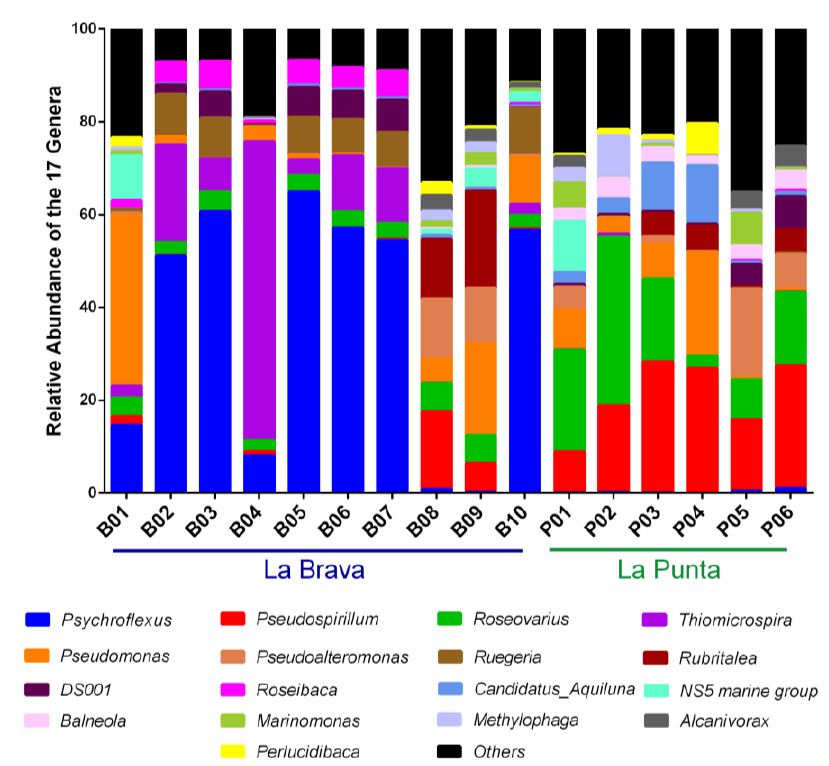
Figure 4. Relative abundance of the genera in the 16 water column samples collected from the La Brava–La Punta lake system. Seventeen genera are responsible for 64.80% to 93.31% of the relative abundance observed.